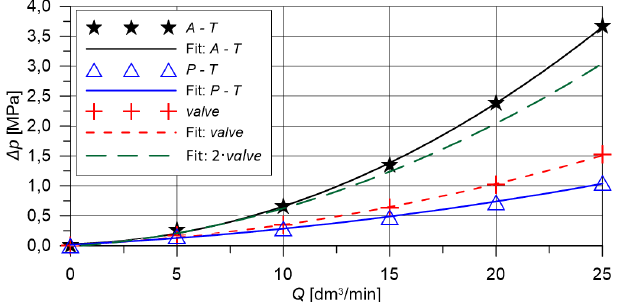
Figure 15. Comparison of pressure drop over the flow paths containing two seat valves connected in series; A − T and P − T .